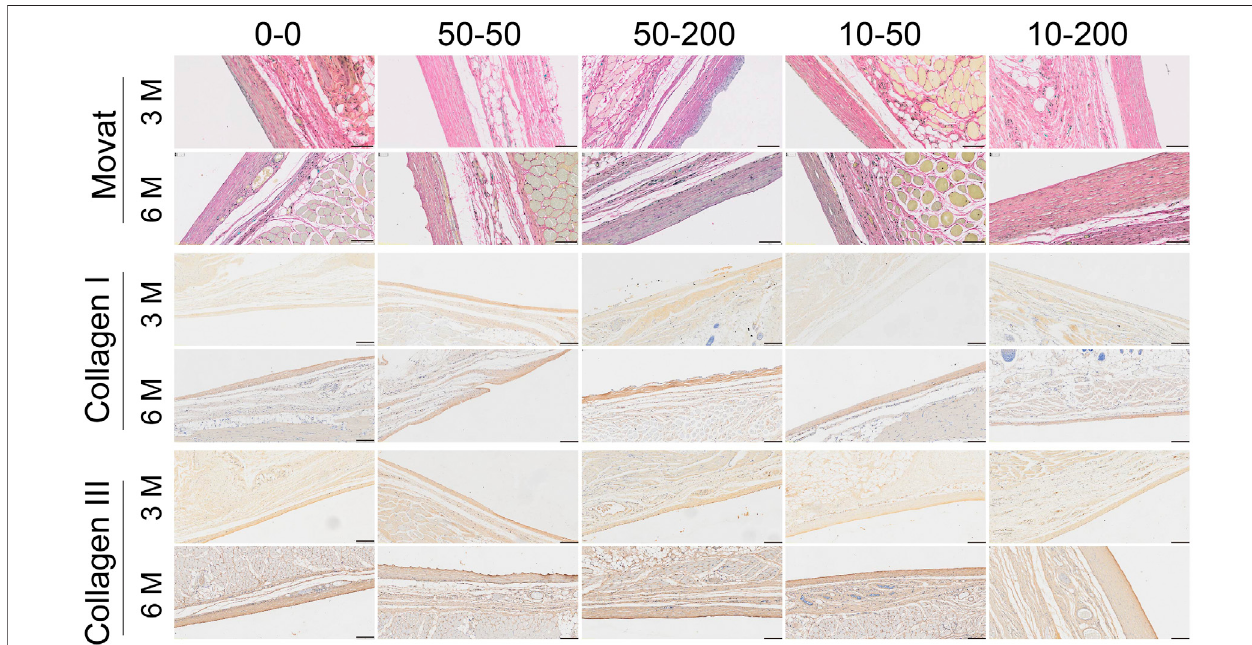
FIGURE10| Effectofsurfacetopologyoncollagenformationanddeposition.RepresentativeresultsofMovatstaining,typeIcollagen,andtypeIIIcollagenstaining (scale bar (cid:2) 200 μ m).